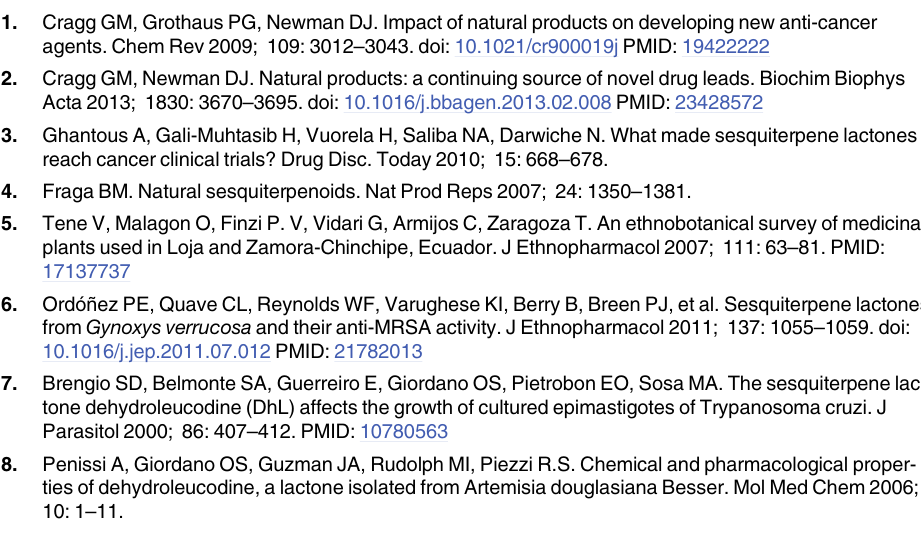
S1 Fig. NMRs Spectrum correspond to the